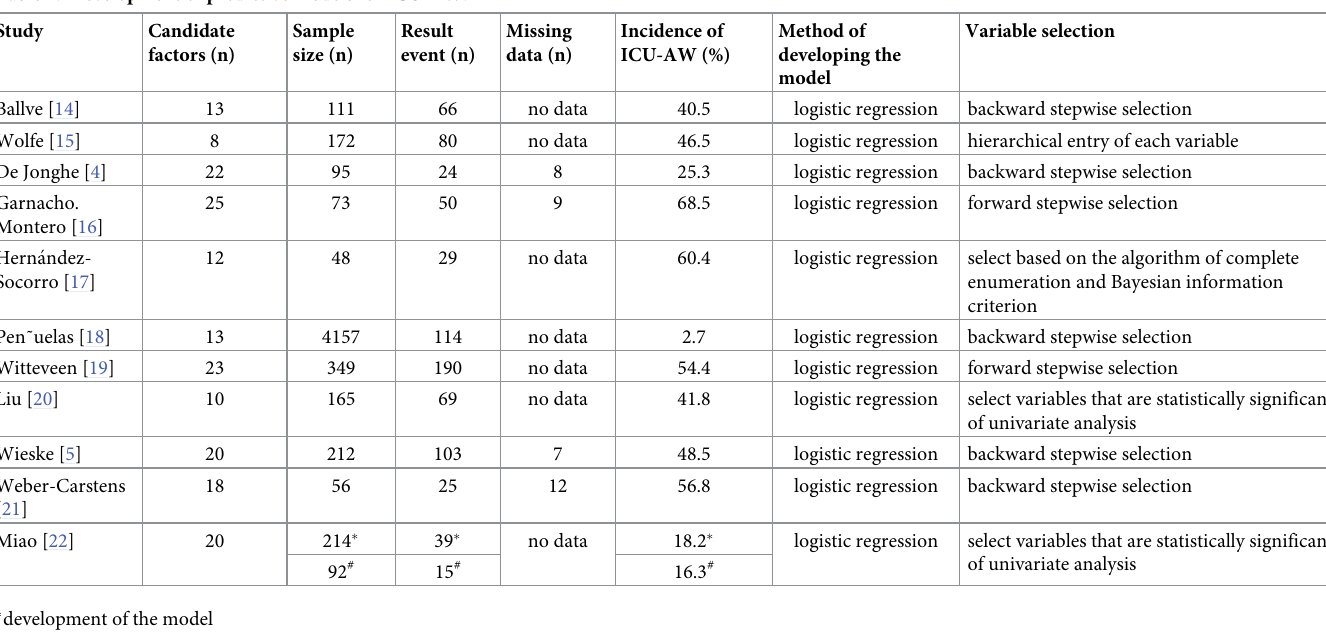
Table 2. Development of predictive models for